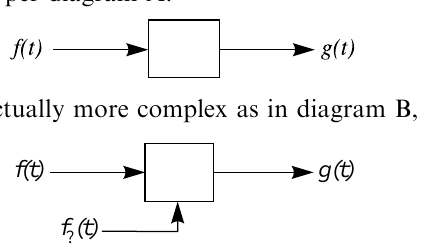
Table 3. Autocorrelation functions (note: the correlations Q ff are for the functions f (cid:133) t (cid:134) (cid:255) f av , where (cid:137) z (cid:138) (cid:136) 2 : 97; the time-spans are 1890–1990 for z (cid:133) t (cid:134) , 1755–1990 for z 11 (cid:133) t (cid:134) , and 1740–1990 for Dz 11 (cid:133) t (cid:134) ) (cid:137) Dz 11 (cid:138) av